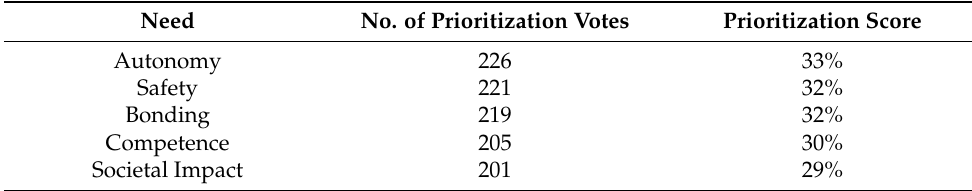
Table 4. Prioritization Results for the Target Group “Family”.